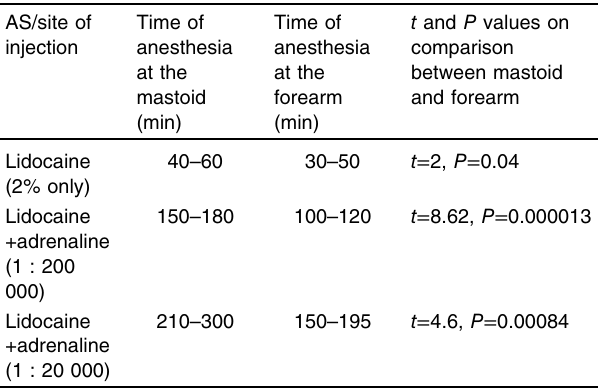
Table 3 The time of local anesthesia using lidocaine 2% with different adrenaline concentrations at two different sites (forearm and mastoid) AS/site of